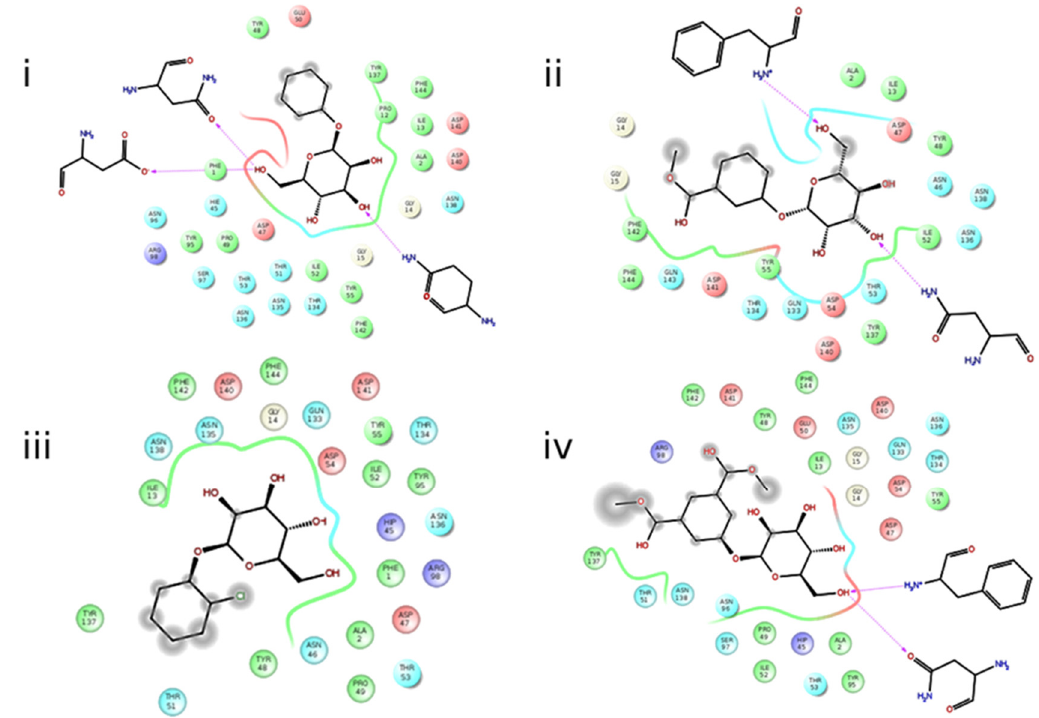
Figure 1. Interactions between proteins and ligands. ( i ) Interaction between protein 4XO9 and ligand b . ( ii ) Interaction between protein 4XO9 and ligand g. ( iii ) Interaction between 4X5P protein and ligand e. ( iv ) Interaction between 4X5P protein and ligand j.